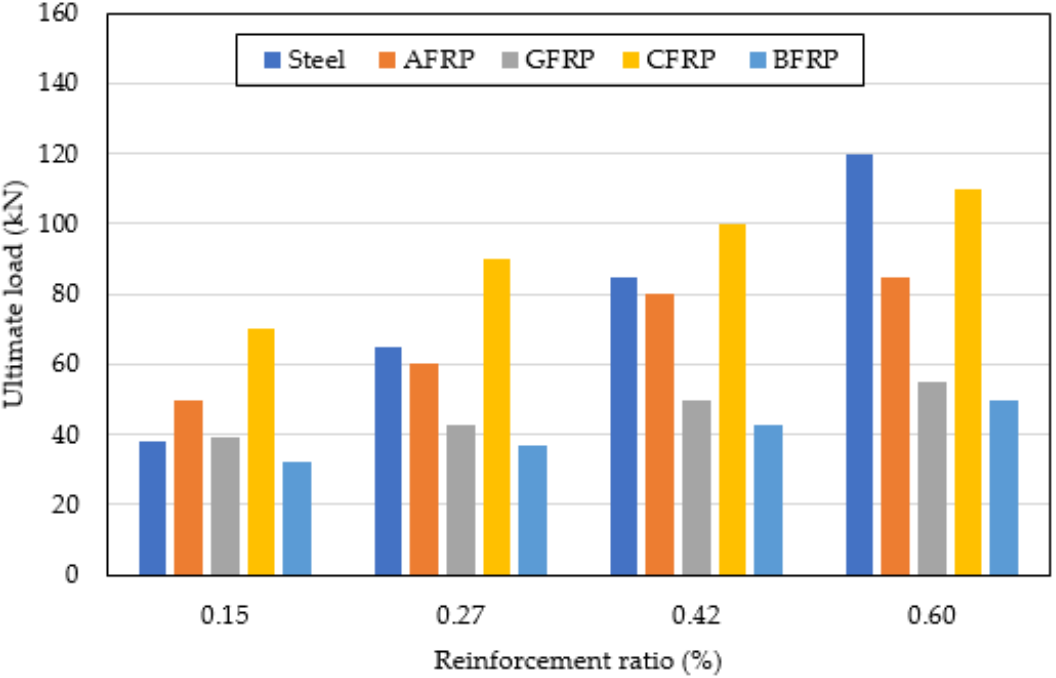
Figure 6. Ultimate load vs. reinforcement ratio.